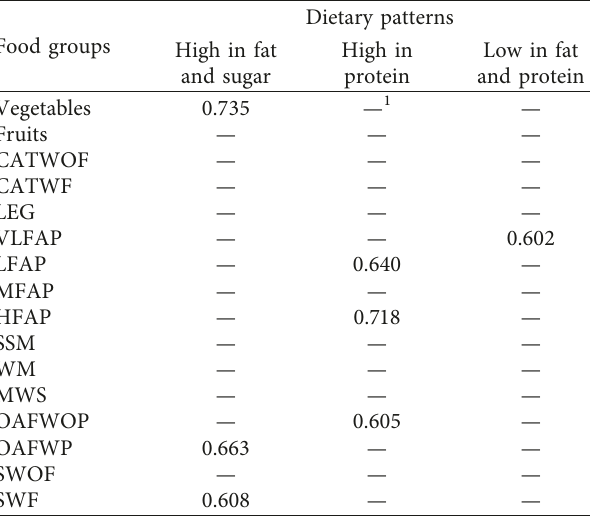
Table 5: Load factors according to the factorial analysis. Food groups